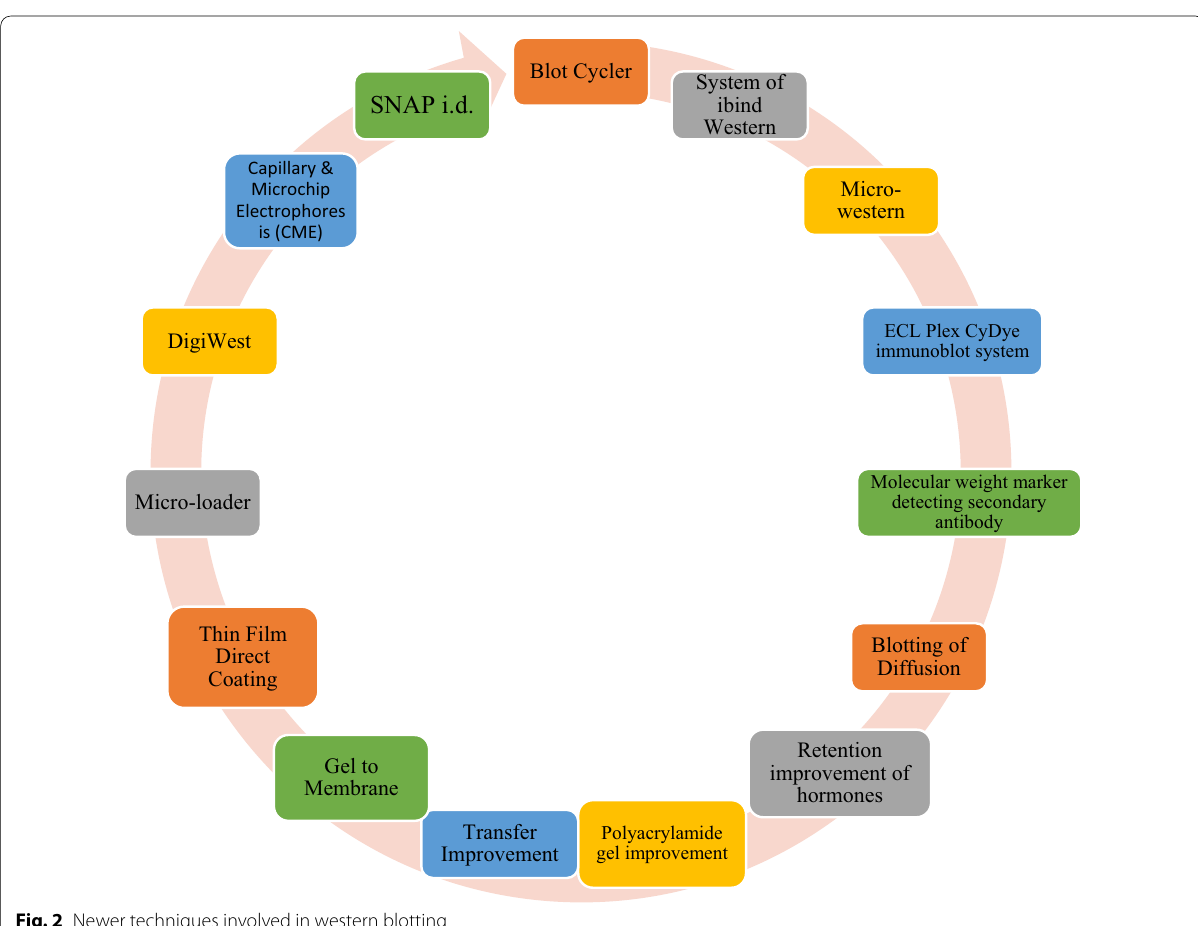
Fig. 2 Newer techniques involved in western